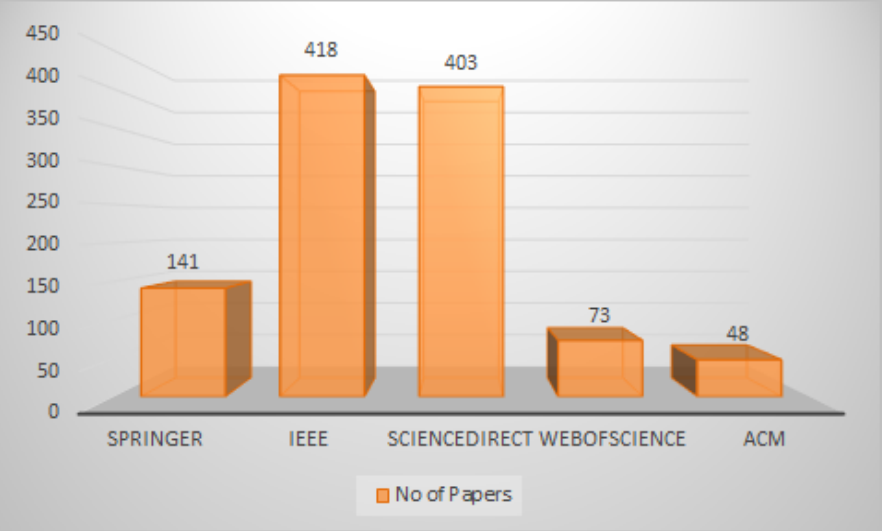
Figure 2. Number of papers